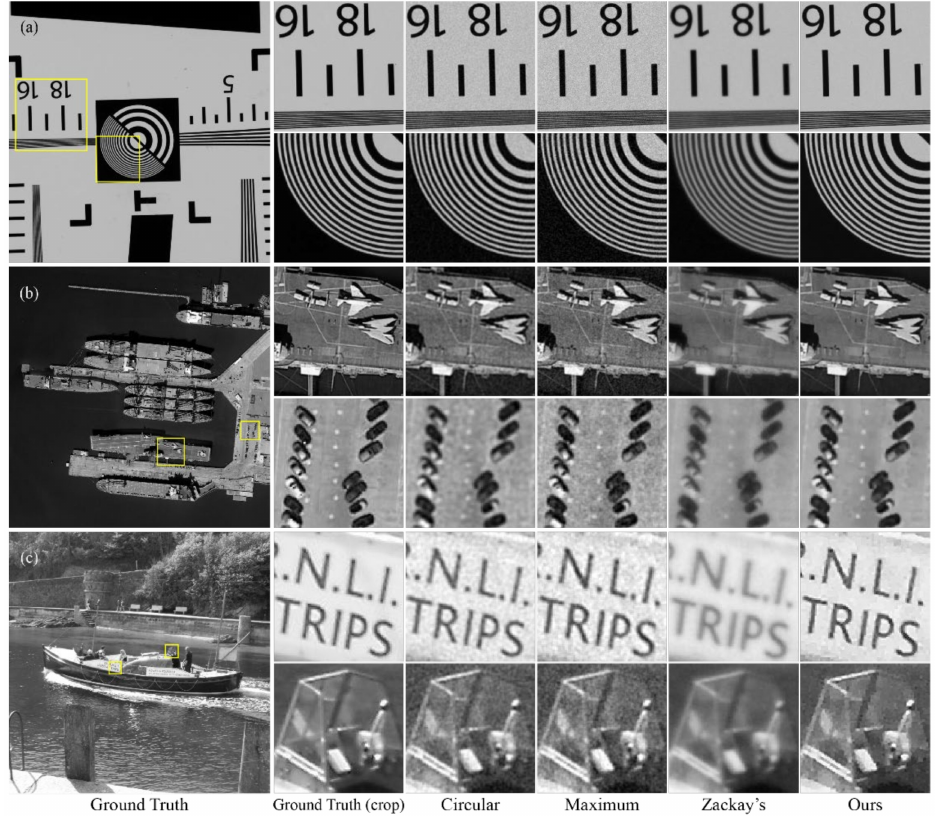
Figure 9. Comparison of different reconstruction results. ( a ) Zoomed areas of different methods’ reconstruction results of the ISO12233 target; ( b ) Zoomed areas of different methods’ reconstruction results of the wharf target; ( c ) Zoomed areas of different methods’ reconstruction results of the boat target; Our algorithm synthesizes multiple frames to suppress noise and can reconstruct more